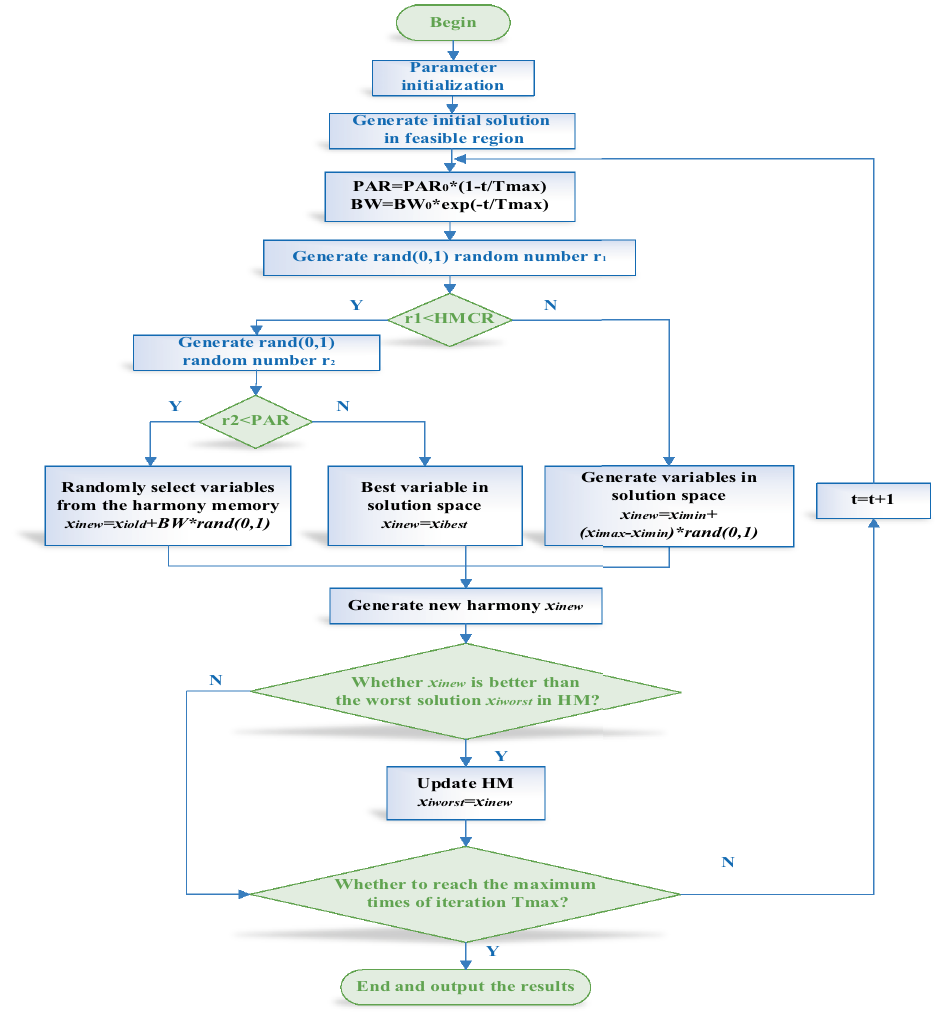
Figure 6. The flow chart of